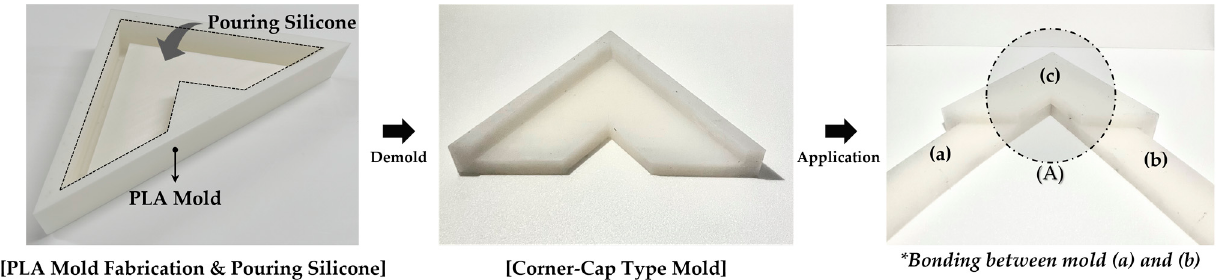
Figure 4. Corner-Cap-Type Mold.